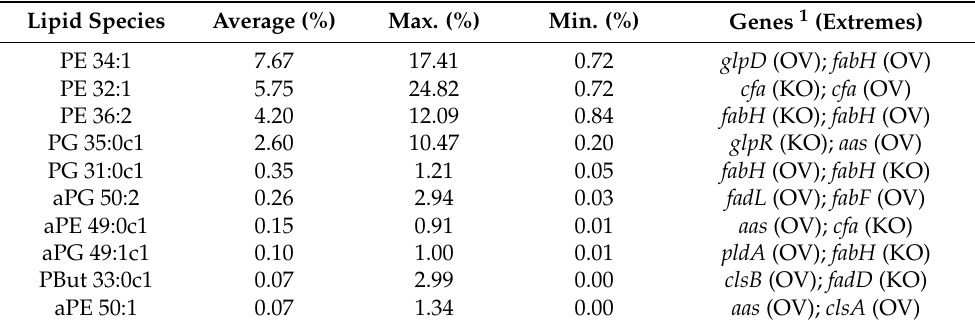
Table 1. Most informative lipid species for the classification of genetic composition and n -butanol exposure (yes/no) as identified by random forest analysis. Percentages are given as contributions to the total mass spectrometry